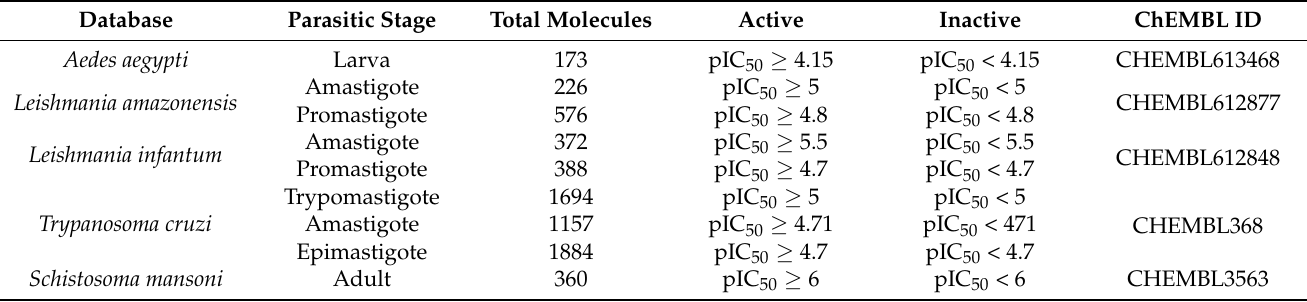
Table 13. ChEMBL